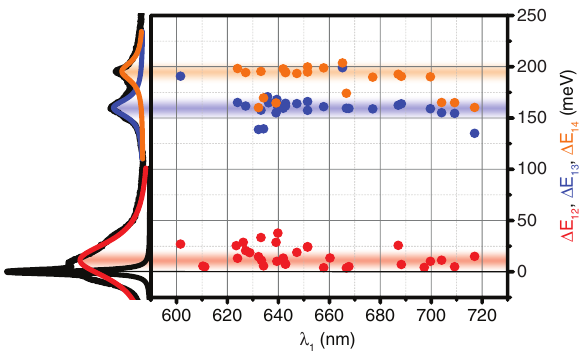
Figure 4: Spectral line position data extracted from 30 emitters that show comparable spectral fingerprints as explained in the main